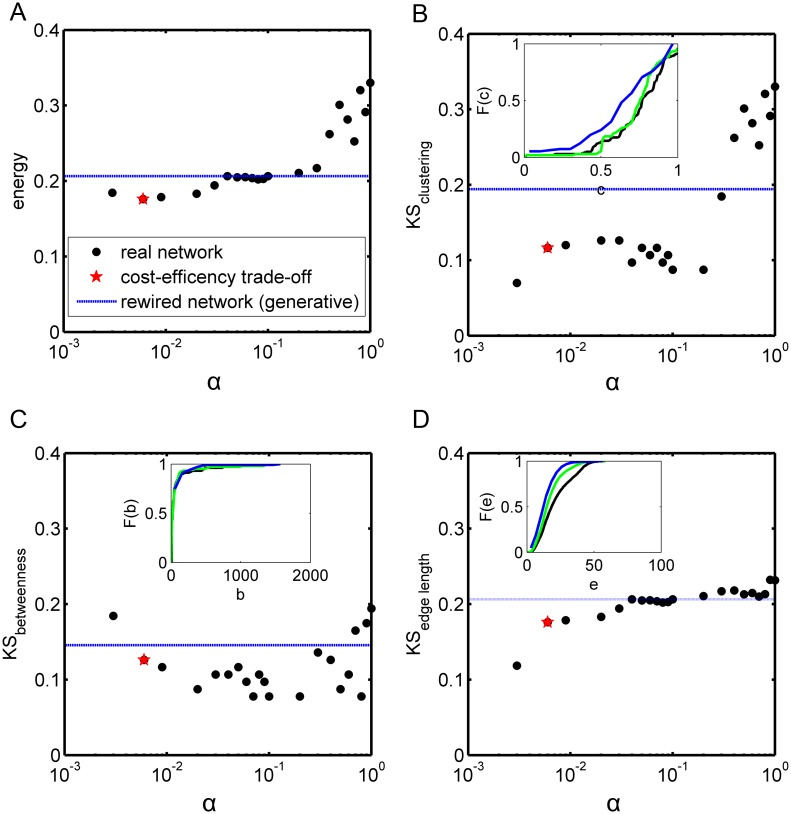
The recovery of different statistical features of the real networks by the cost-efficiency trade-off model and the optimal generative model.(A-D) show the behavior of energy (A), Kolmogorov-Smirnov statistics KSclustering (B), KSbetweenness (C), and KSedge length (D) as a function of α (bullets) by the cost-efficiency trade-off model. The red stars represent the corresponding results at α = 0.006. Blue dash lines show the corresponding results for the optimal generative model with fixed degrees. Inset in (B), (C) and (D): Cumulative distribution of clustering coefficient, betweenness centrality, and edge length for the real cortical network (black line), for the cost-efficiency trade-off model at α = 0.006 (green line), and for the generative model with fixed degrees (red line).